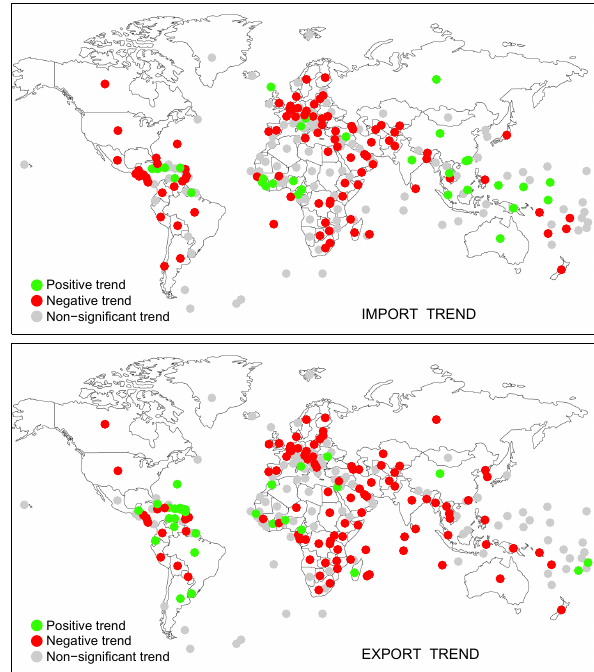
Fig. 7. Spatial representation of the trend signs for the mean distance travelled by virtual water imported (above) and exported (below) by each country from/to the rest of the world.